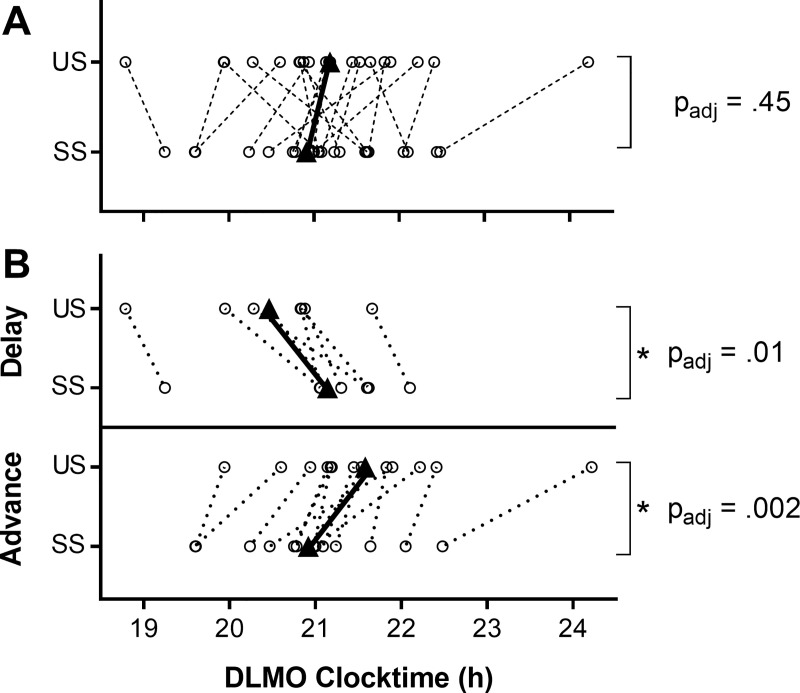
Changes in circadian phase between unstructured and structured sleep.A: All participants; B: The group split by the direction of the phase shift that occurred. US: Unstructured Sleep; SS: Structured Sleep. Black triangles joined by black line show group mean; circles show individual data. padj: False Discovery Rate adjusted p-value; *Statistically significant result.